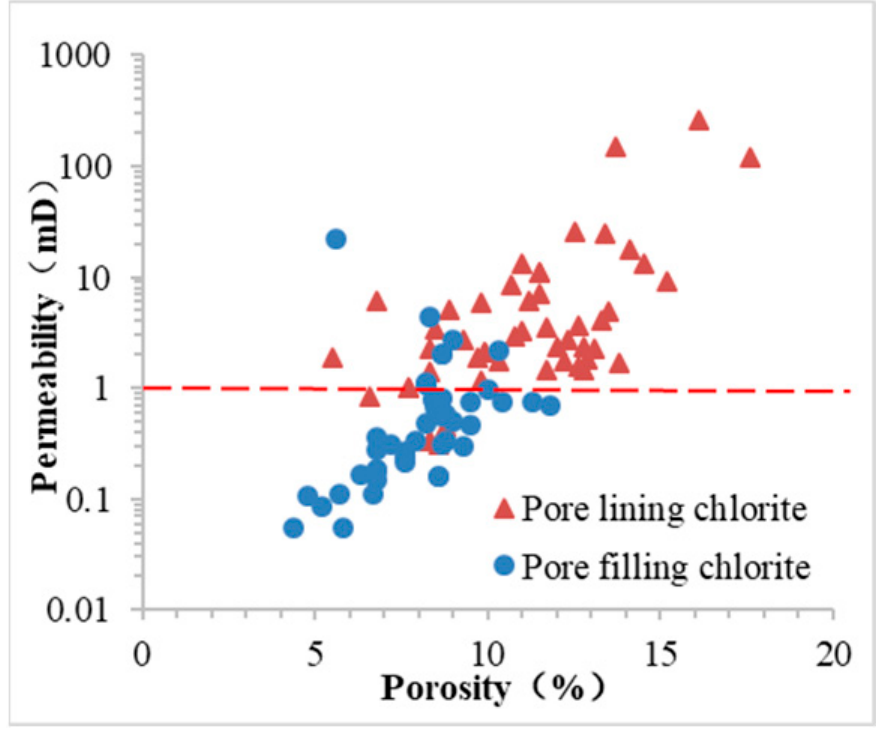
Figure 6. Types of chlorite and their effects on the reservoir.